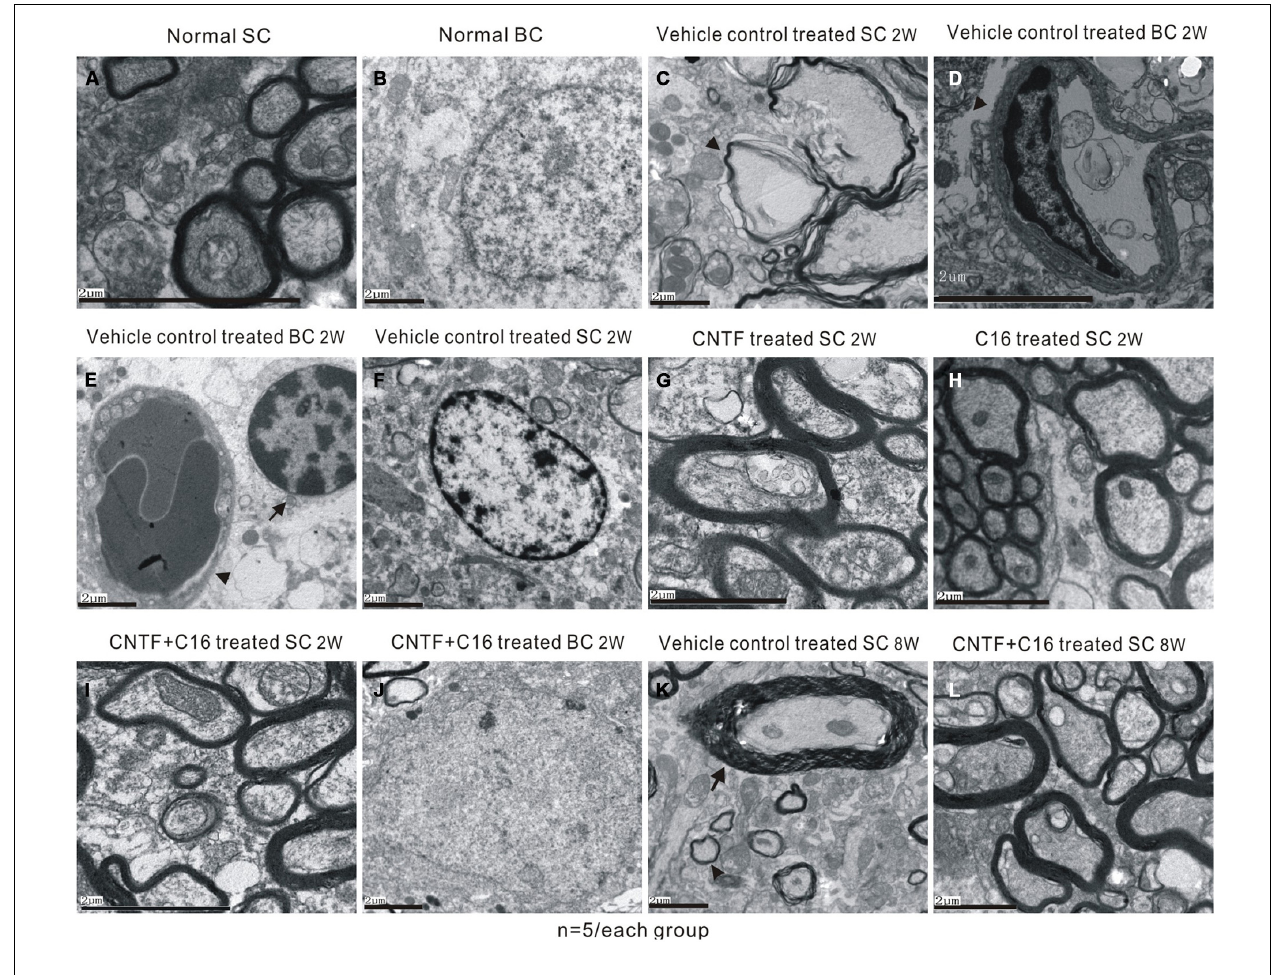
(showed by arrow) near the vascular endothelial cell (showed by red arrowhead). (F) The neurons of the vehicle control showed apoptotic signs of shrunken nuclei with condensed, fragmented, and marginated nuclear chromatin.The CNTF − (G) , C16 − (H) , and C16 + CNTF-treated (I) groups exhibited more lightly vacuolated myelin sheaths.The neighboring nuclei (J) of C16 + CNTF-treated rats resembled the normal ultrastructure. At week 8 post-immunization in the vehicle control group, demylination (arrow) and remyelination (arrowhead) simultaneously appeared in vehicle-treated EAE rats (K) . Meanwhile, more remyelinated fibers appeared in C16 + CNTF-treated (L)